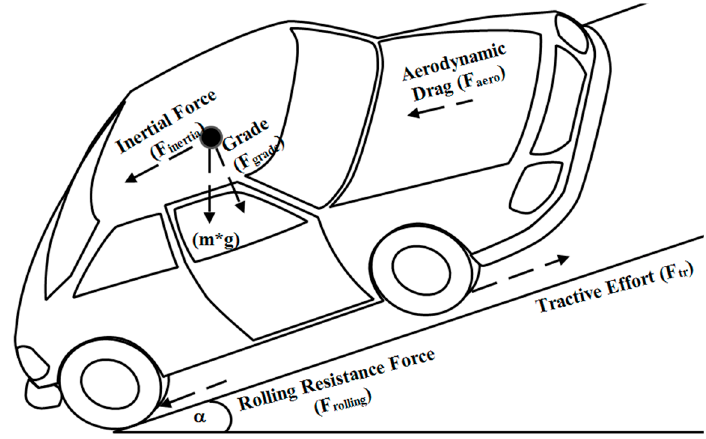
Figure 4. Tractive forces allied on eCAR.